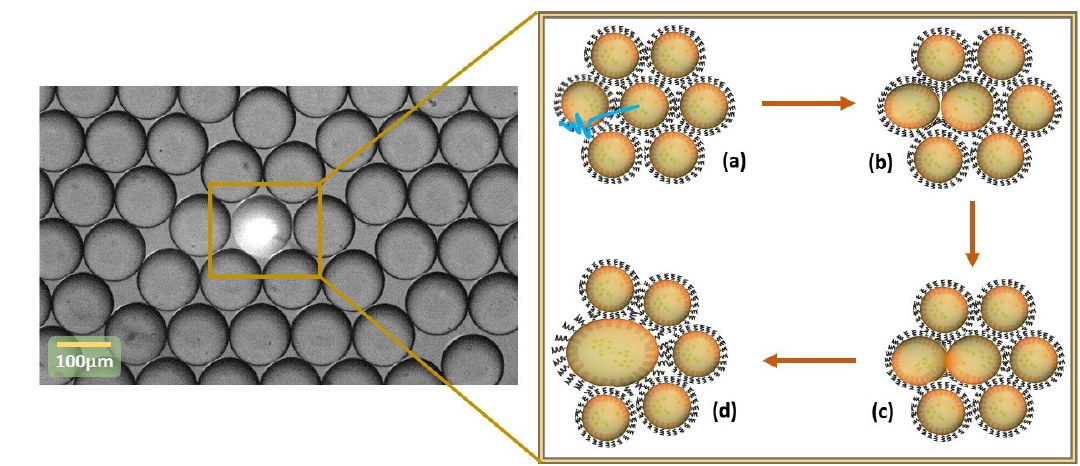
Figure 1. Light-driven merging process principle. ( a ) Targeting droplets and change of surface activity of the surfactant molecules at the droplet surface under laser irradiation, ( b ) depletion of the surfactant molecules at the the droplet interface, ( c ) merging induced following UV laser irradiation and the trans to cis photo-conversion, ( d ) targeted droplets after